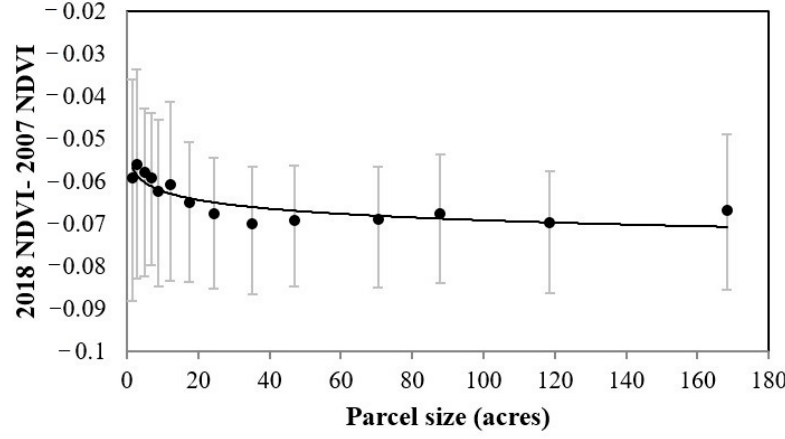
Figure 14. Autumn NDVI change between 2018 and 2007 versus parcel sizes. The black point is mean value of each bin, the error bar is the 0.25–0.75 percentiles, and the solid line is the regression line.